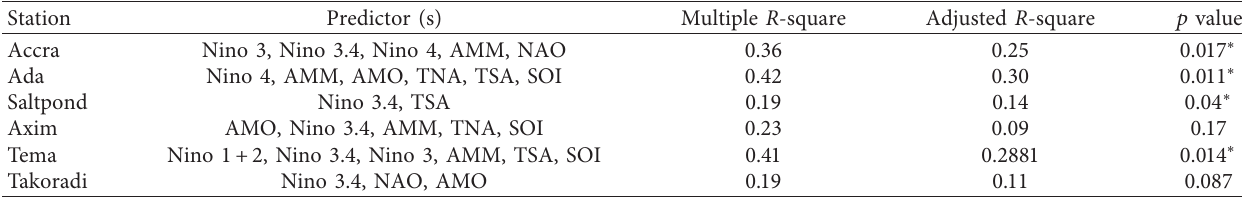
Table 5: Summary of stepwise regression results between NDJ SPI and OND climate indices. Station